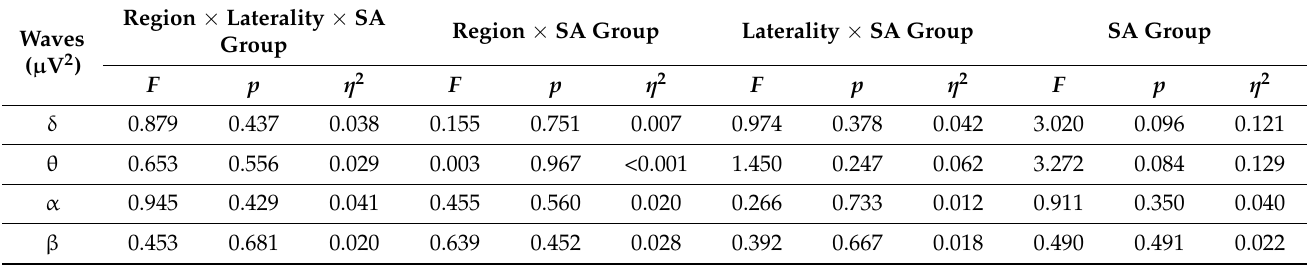
Table 1. ANOVA results of absolute power for the two SA groups.